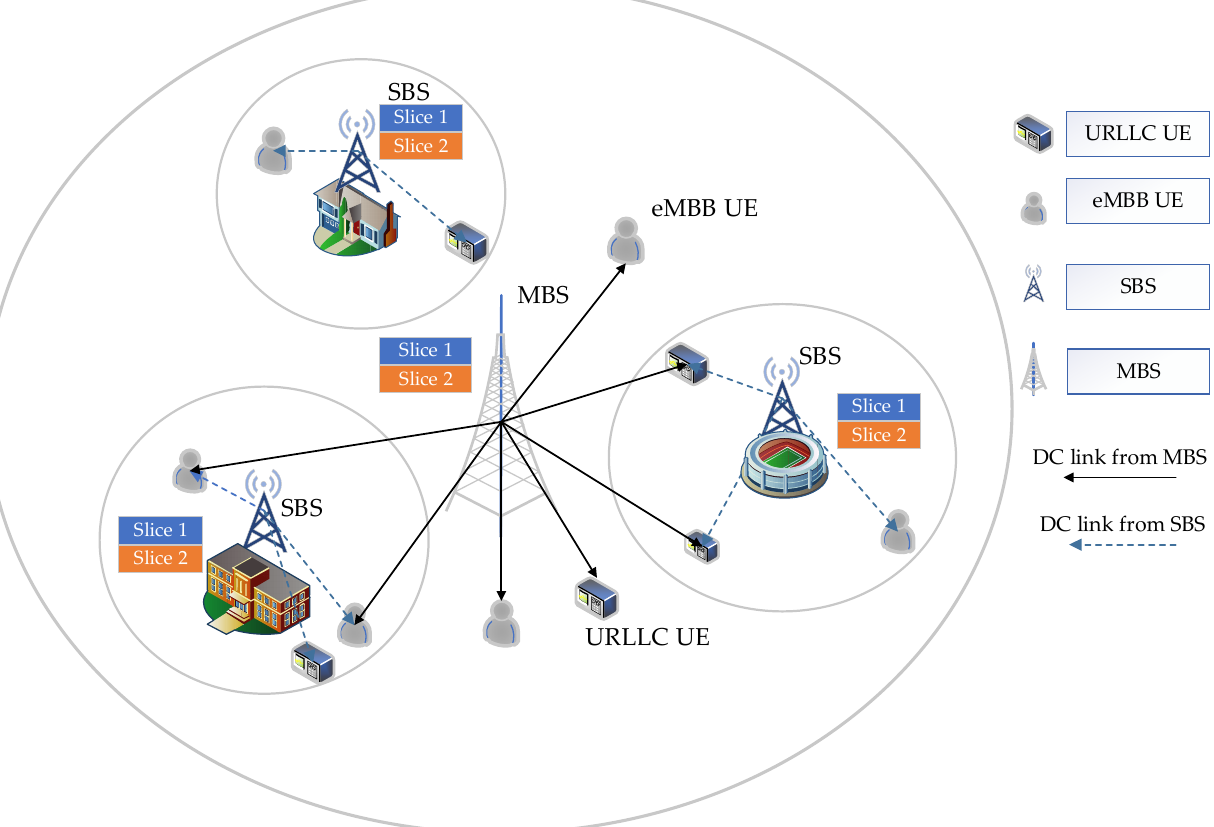
Figure 1. An illustration of the system model.